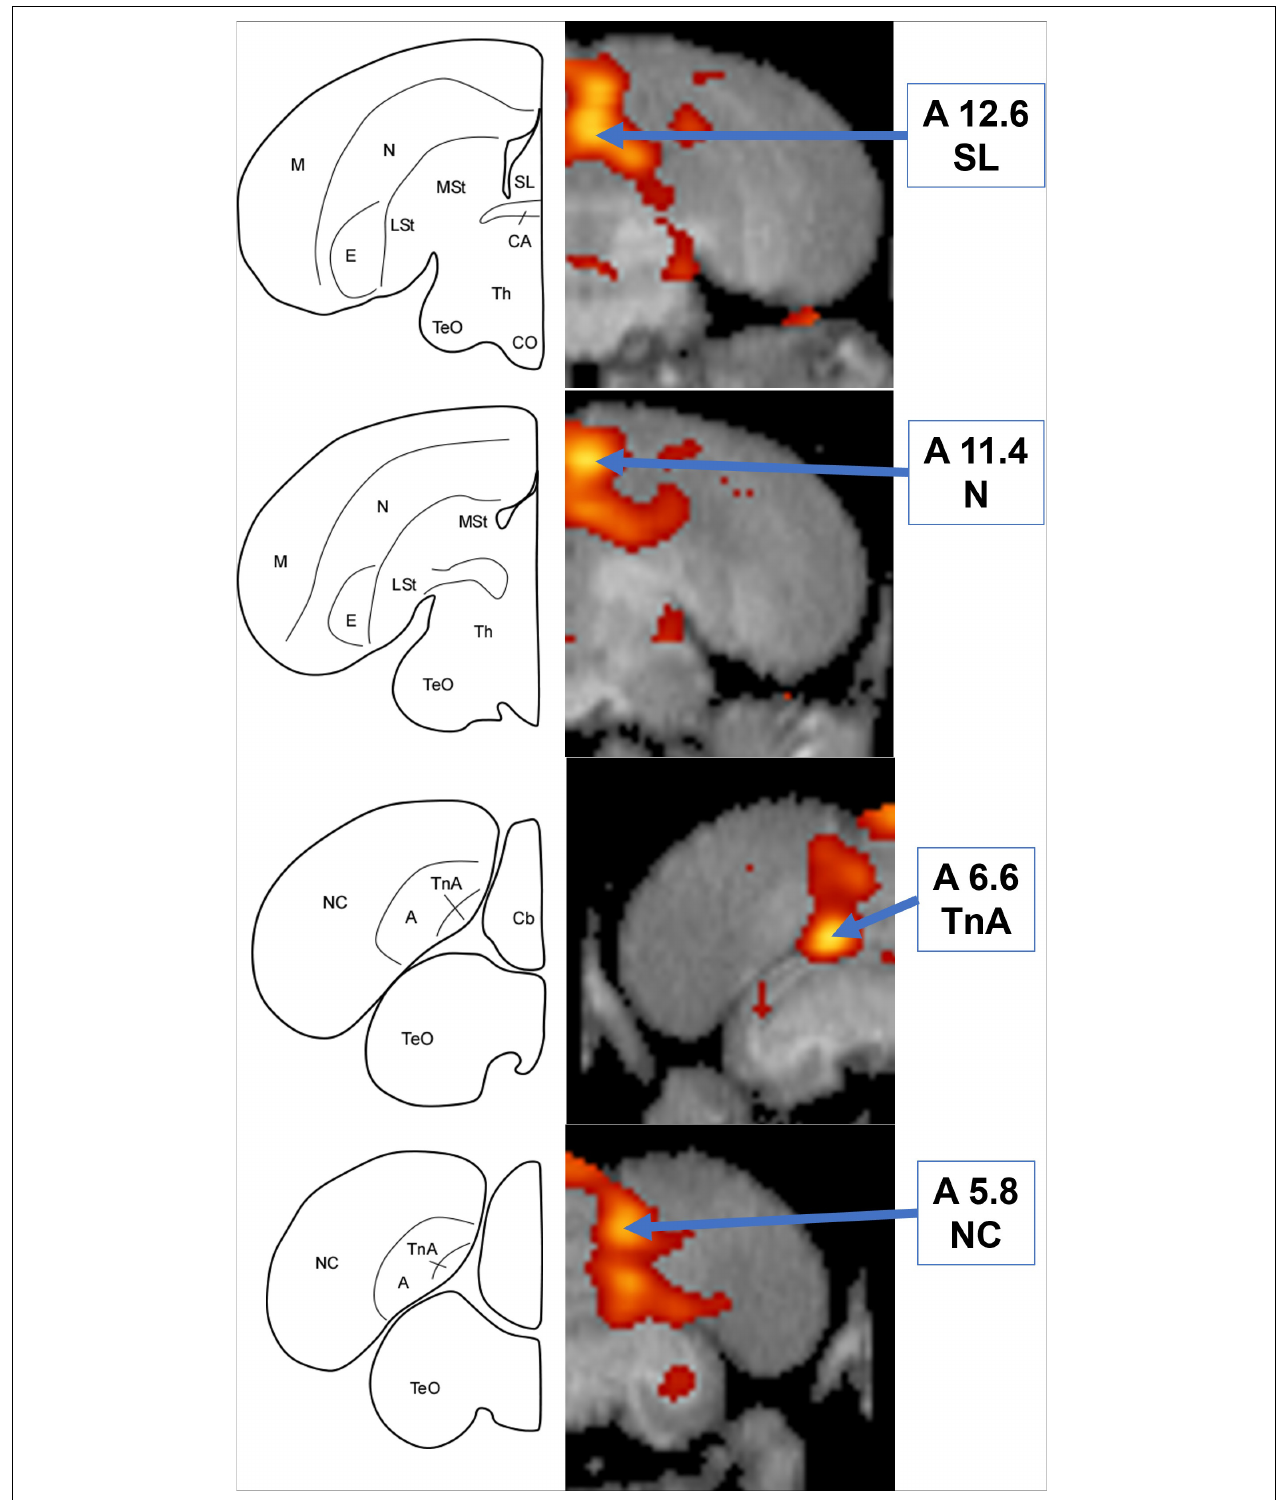
FIGURE 5 | Left: Schematic coronal hemisections of the American crow brain, drawn based on structural MRI and Izawa & Watanabe jungle crow atlas. Cb, Cerebellum; TnA, nucleus taeniae of the amygdala. For other abbreviations, see Figure 3 . Right: Coronal view of voxel-wise subtractions (converted to Z-scores) showing differential brain activity at the indicated region for all crows simultaneously exposed to the audio and visual stimuli ( n = 4). Brain activity is superimposed atop a composite ( n = 4) structural MRI of the American crow brain.